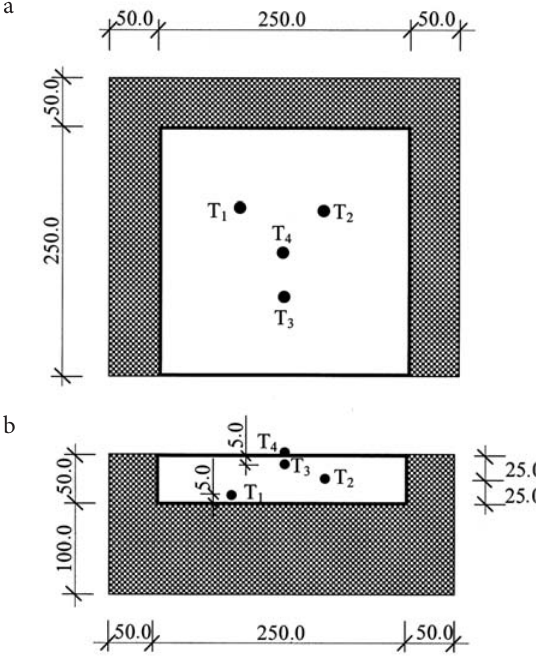
Fig. 2. The plan of thermocouples distribution to measure temperature in HMA samples being cooled: a – a view from bird’s eye; b – transversal section of the sample (measures on